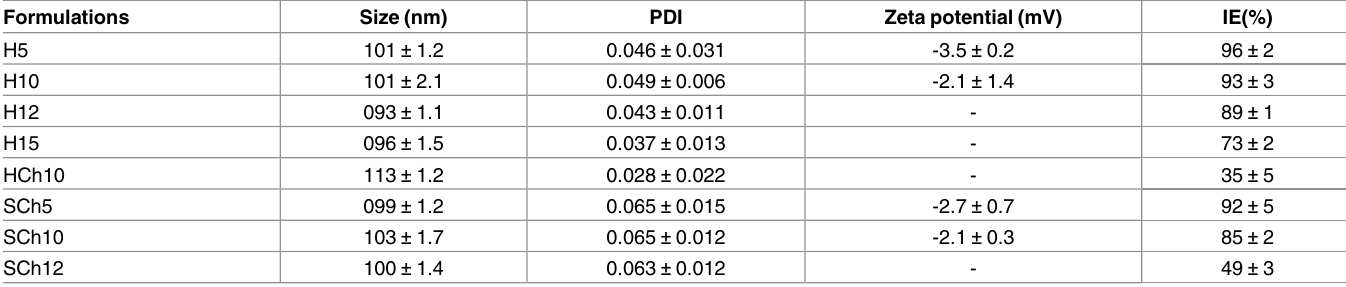
Table 2. Characteristics of the Cur-loaded liposomal formulations.